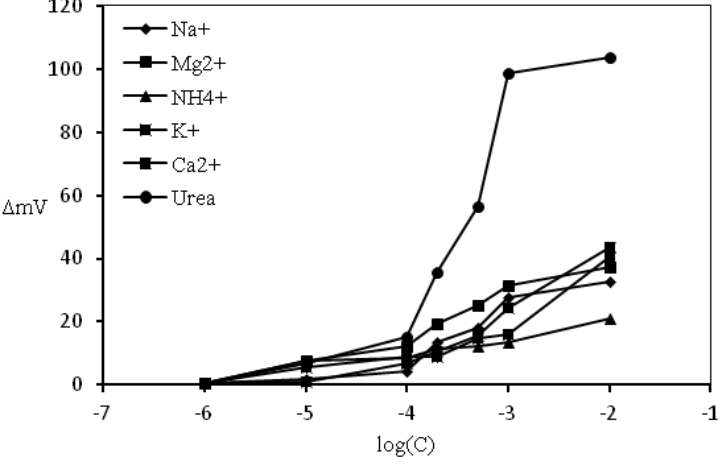
Figure 9. Comparison of sensitivity for the urea biosensor electrode to urea and some other cations.